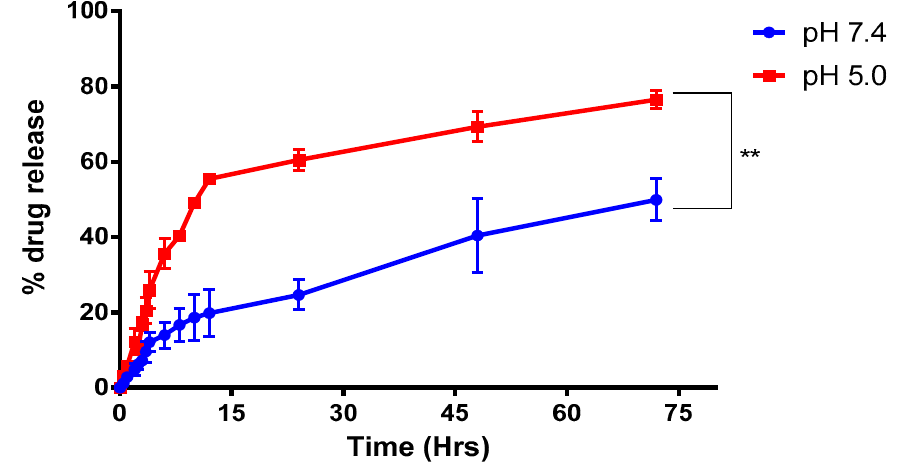
Figure 5. Release pattern observed at pH 7.4 and pH 5.0 for BSA-CDF-ATZ, each representing the normal cell pH and tumor microenvironment, respectively. The higher uptake in the pH 5 confirms better performance and more targetability in the tumor microenvironment in TNBC. Experiments were performed in triplicates; results are shown mean ± SD; **P ≤ 0.01.